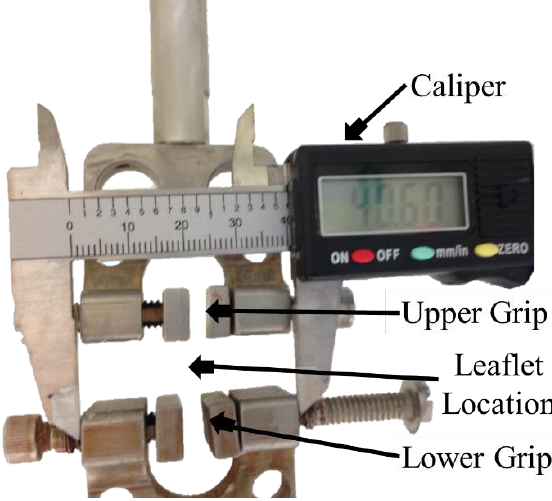
Figure 1. Leaflet strip set-up in mechanical test instrument (Electroforce 2300 with Wintest 7 software control, TA instruments) to facilitate specimen cyclic flexure (bending and straightening events).